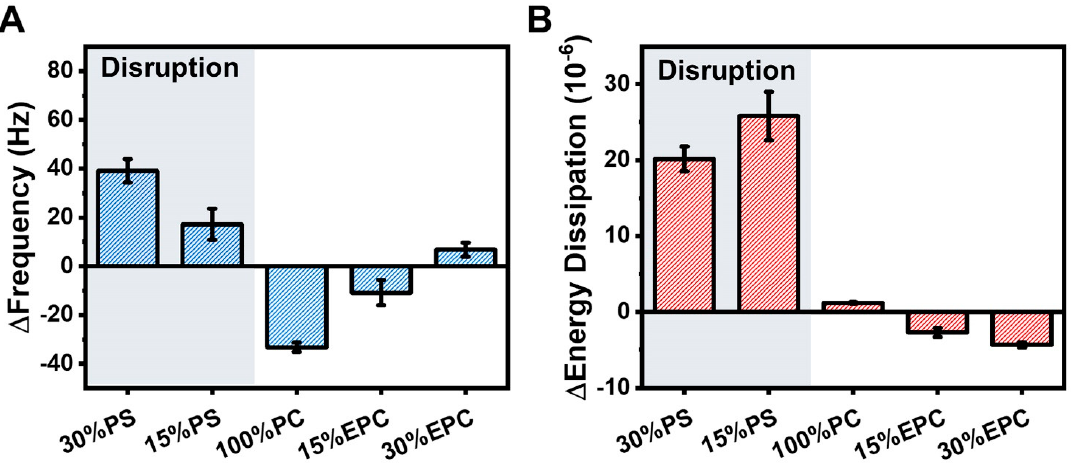
Figure 4. Summary of QCM-D measurement responses for LTX-315 peptide interactions with intact vesicle adlayers. Maximum responses of the ( A ) Δ f and ( B ) Δ D shifts are presented based on the data in Figure 3 and reported as the mean ± standard deviation from n = 3 measurements.